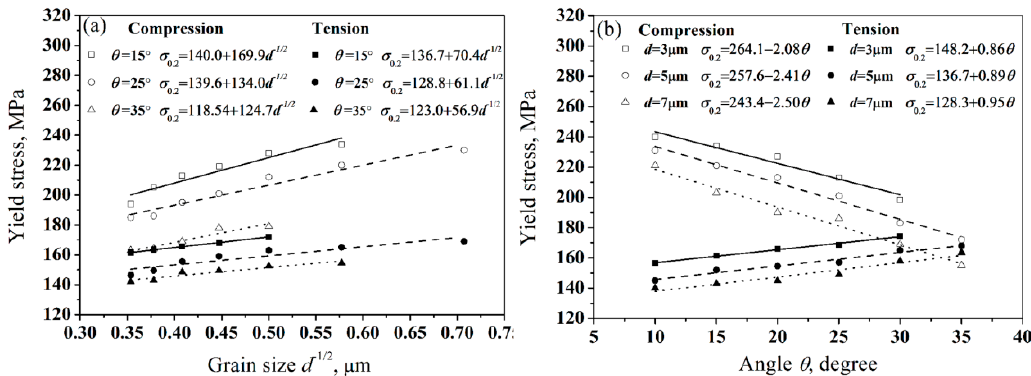
Figure 10. Variations of strengths of CECed ZK61 alloy rods as a function of ( a ) grain size or ( b ) the angle, θ , between the c-axis of grains and the ED in tension and compression.